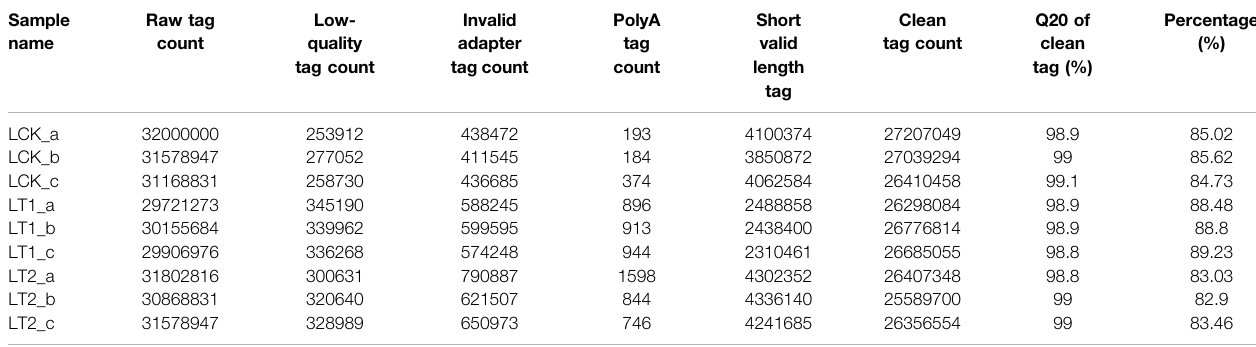
TABLE 1 | Summary of sequencing data for each